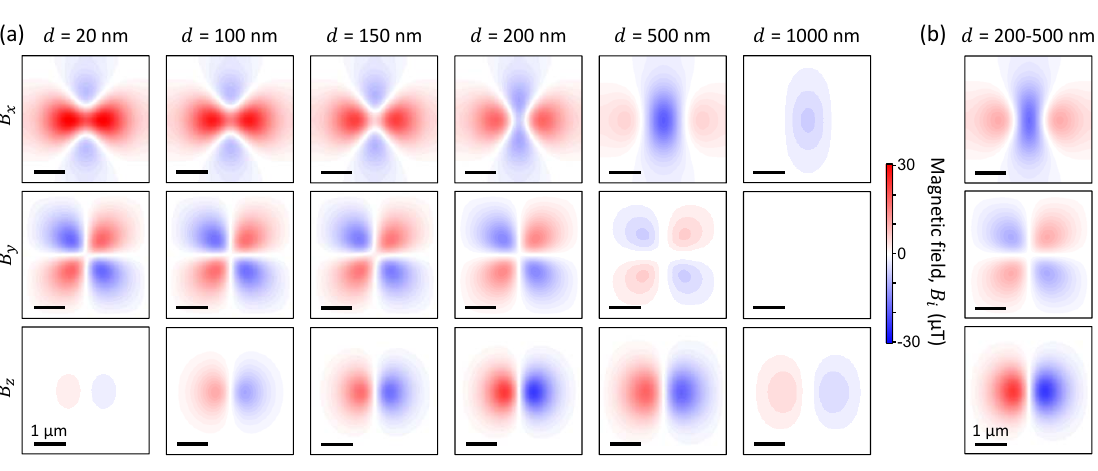
Figure 5. ( a ) Apparent magnetic field simulated with an increasing stand-off distance d from 20 nm (far left) to 1000 nm (far right). ( b ) Apparent magnetic field simulated considering a uniform distribution of NV centres along z between d = 200 nm and 500